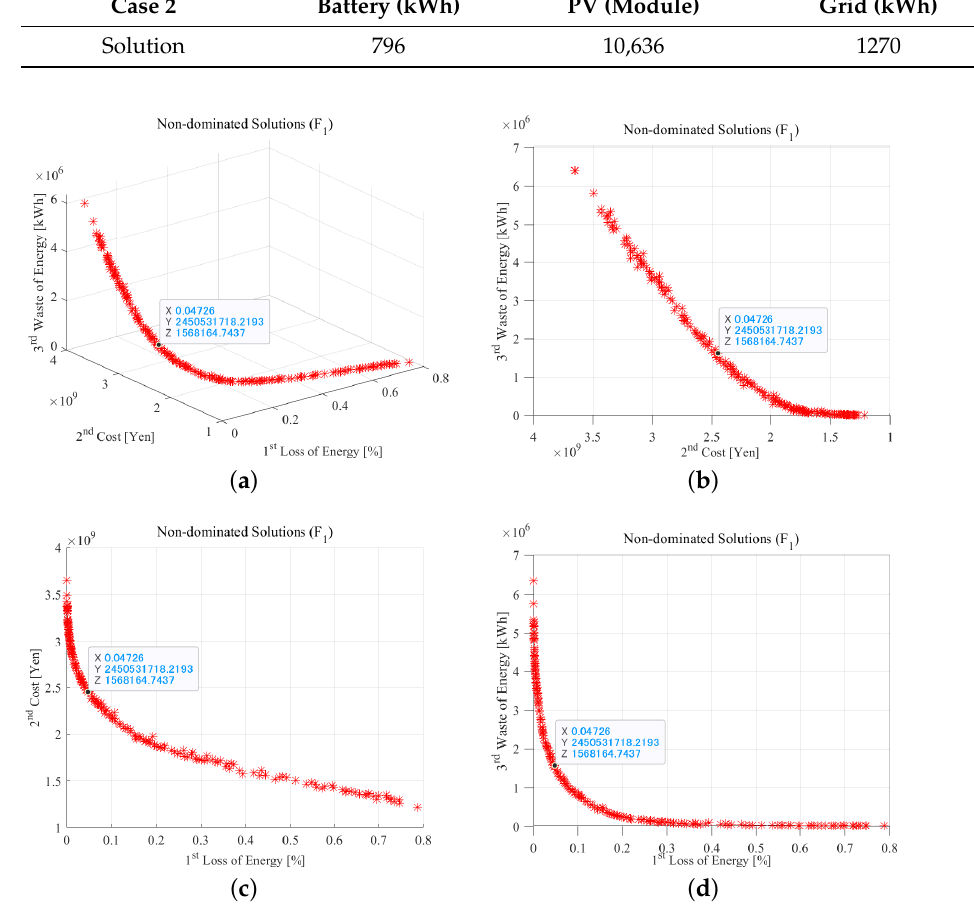
Figure 8. Pareto front results of Case 2. ( a ) 3D Pareto front; ( b ) Pareto front with LCC and WE; ( c ) Pareto front with LSPS and LCC; ( d ) Pareto front with LSPS and